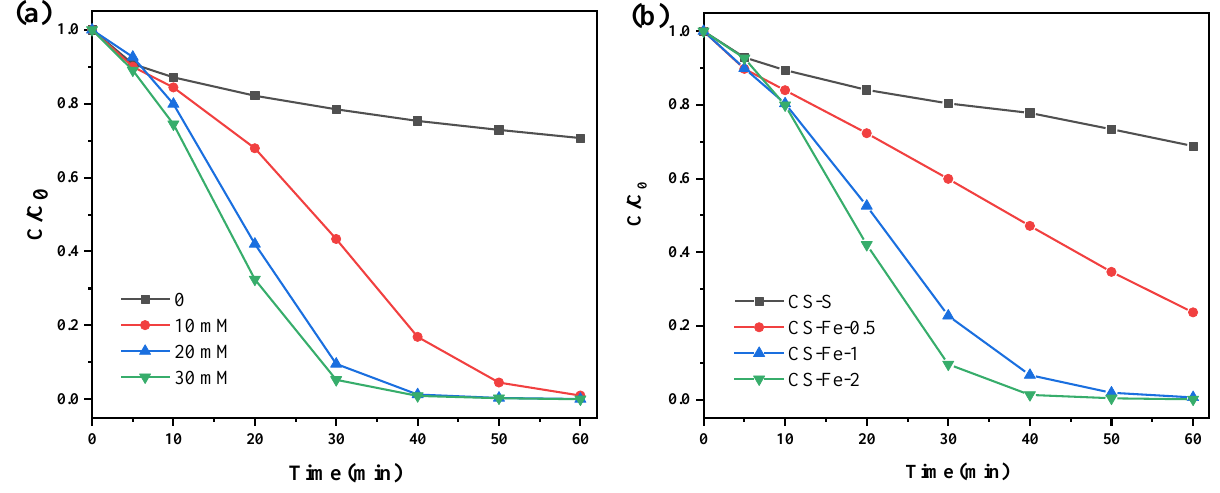
Figure 5. ( a ) Degradation of AR 73 by CS-Fe-2 at different H 2 O 2 dosages; ( b ) degradation of AR 73 by different catalysts at a H 2 O 2 dosage of 20 mM (catalyst dosage: 1 g/L; AR 73: 50 mg/L; time: 60 min; pH: 6.8).